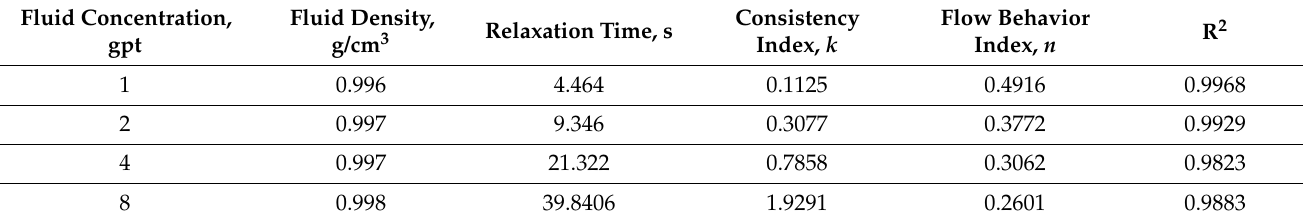
Table 2. Rheological properties of HVFRs using different concentrations at 25 ◦ C.